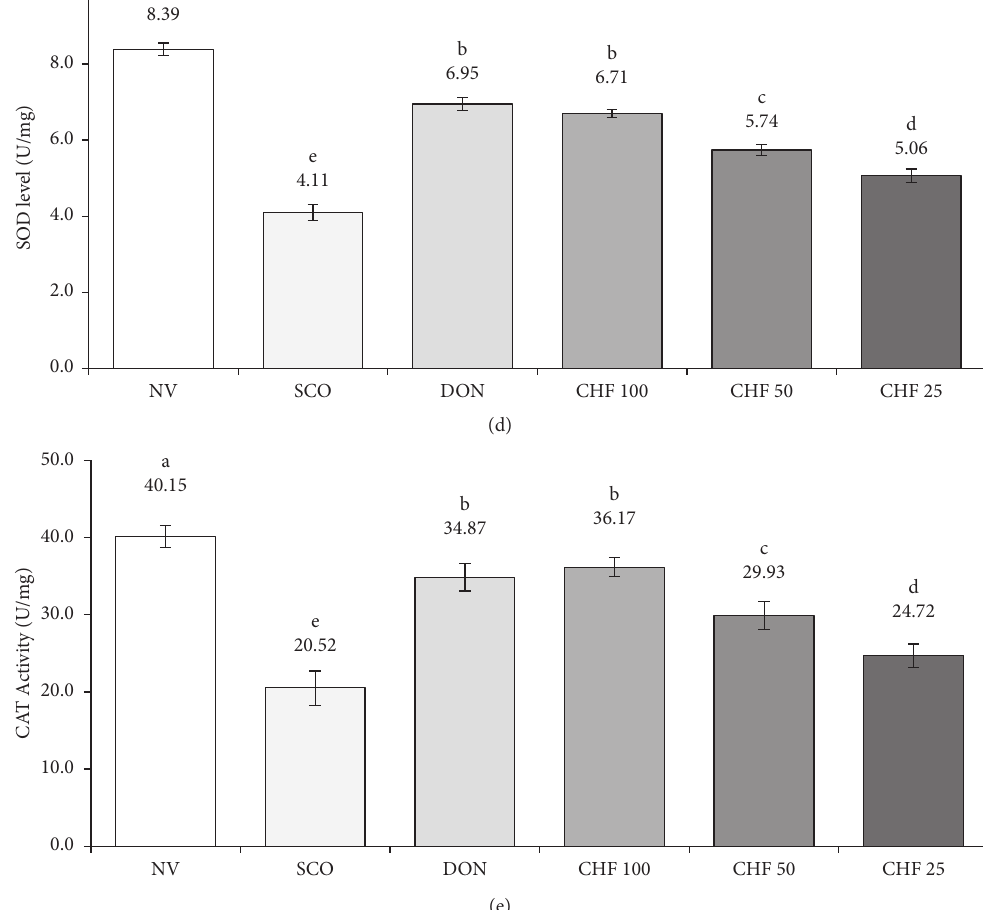
Figure 6: Effect of CHF on brain AChE activity and oxidative stress biomarkers in the scopolamine-induced mouse model . (a) AChE activity, (b) rGSH level, (c) MDA level, (d) SOD activity, and (e) CATactivity in the brain of different groups of mice. Means with different letters (a-f) differ significantly ( P < 0 . 05), where all the drug-treated groups were significantly different ( P < 0 . 05) from the disease control group (scopolamine-treated group). Values were expressed as mean ± STD, n � 6 mice for each group. AChE, acetylcholinesterase; NV, normal vehicle group; SCO, scopolamine; DON, donepezil; CHF, chloroform fraction; rGSH, reduced glutathione; MDA, malondialdehyde; CAT,